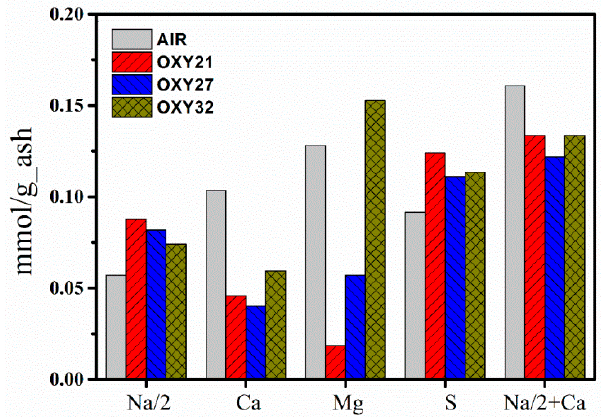
Figure 8. Mole numbers of major inorganic elements in PM 0.5 during air and oxy-fuel combustion.